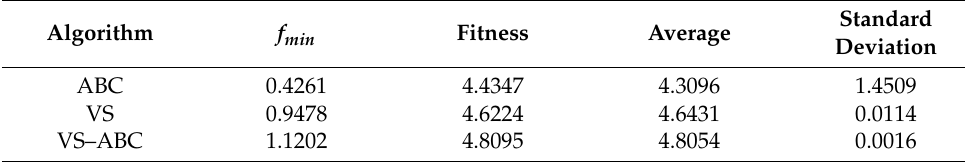
Table 14. The numerical results of Rastrigin.